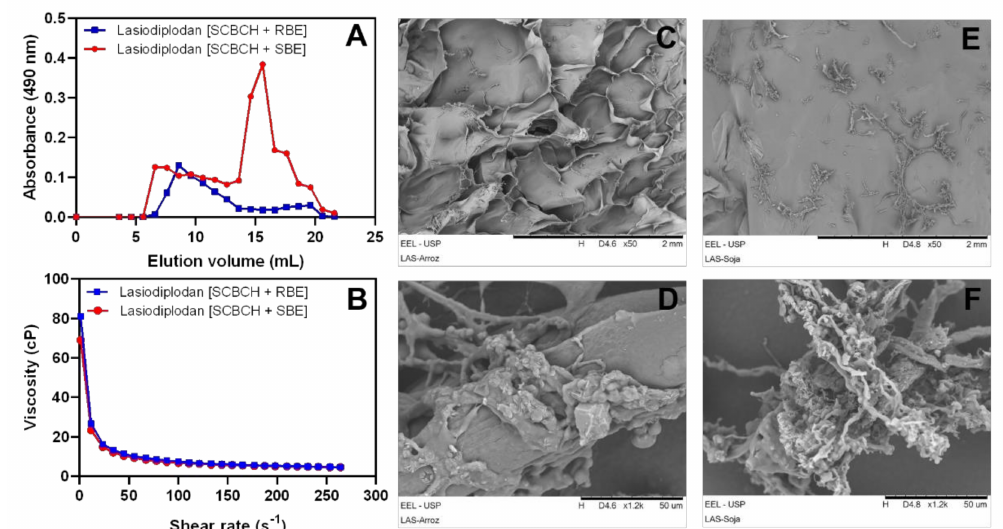
Figure 6. Physical characterization of lasiodiplodan: ( A ) Molecular weight by GPC; ( B ) Appar- ent viscosity; ( C,D ) 50 × and 100 × micrographs (SCBCH/RBE); ( E , F ) 50 × and 100 × micrographs (SCBCH/SBE).